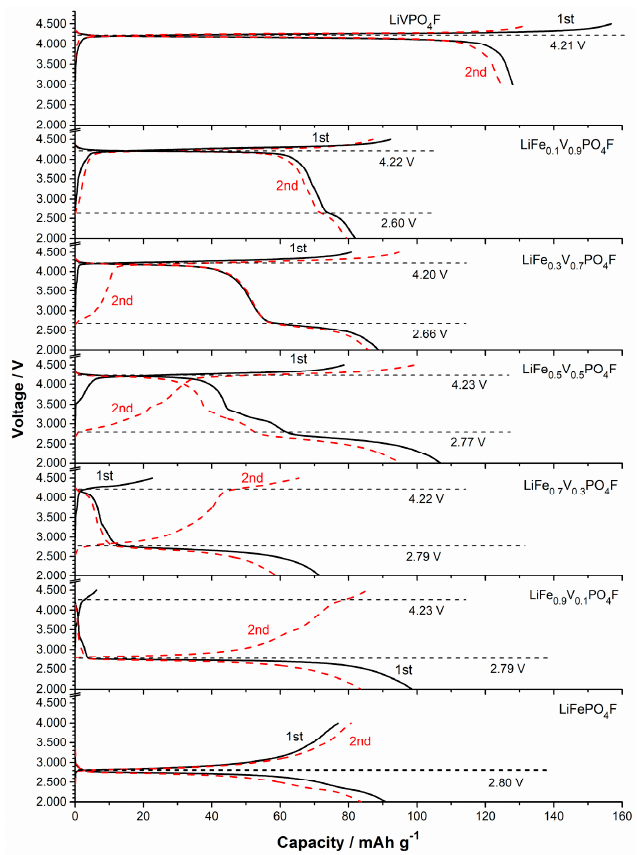
Figure 7. The initial and second charge / discharge profiles of LiFe 1 − x V x PO 4 F ( x = 0, 0.1, 0.3, 0.5, 0.7, 0.9, 1) cells at 0.1 C.